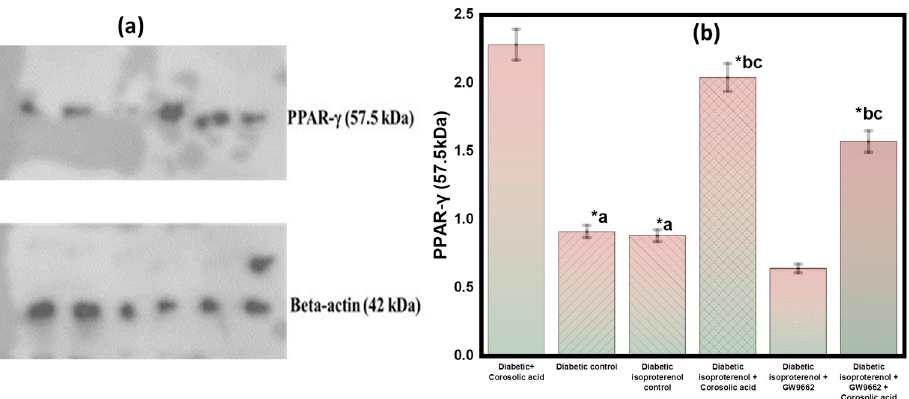
Figure 6. ( a ) PPAR- γ expression. ( b ) The effects of corosolic acid on the expression of PPAR- γ in different groups were quantified by Western blot analysis. The data are expressed as mean ± SEM. * p ≤ 0.05 is considered significant. a normal control vs. diabetic control and diabetic isoproterenol control; b diabetic control vs. corosolic acid and GW9662 treatments; and c diabetic isoproterenol control vs. corosolic acid and GW9662 treatments.